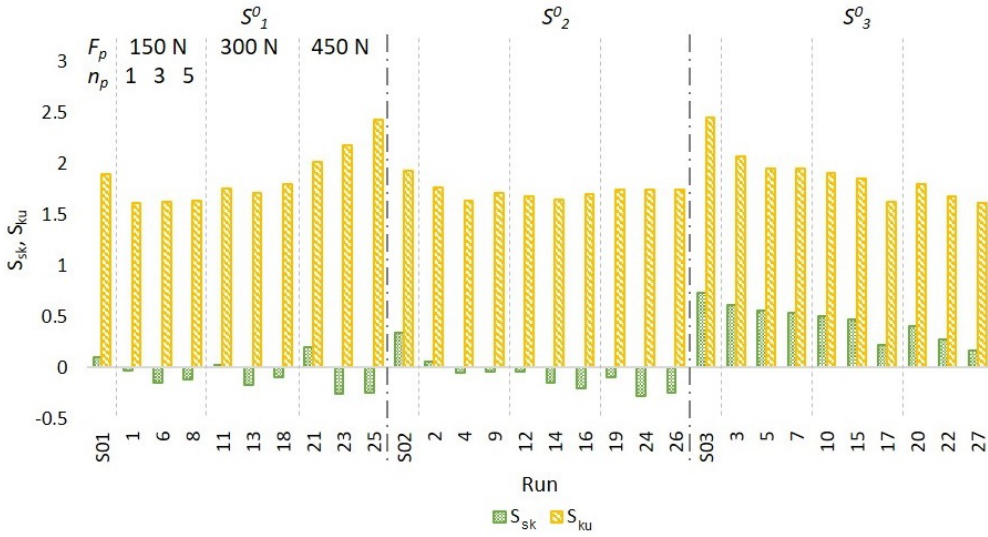
Figure 7. Skewness and kurtosis S parameters that characterize all surfaces after